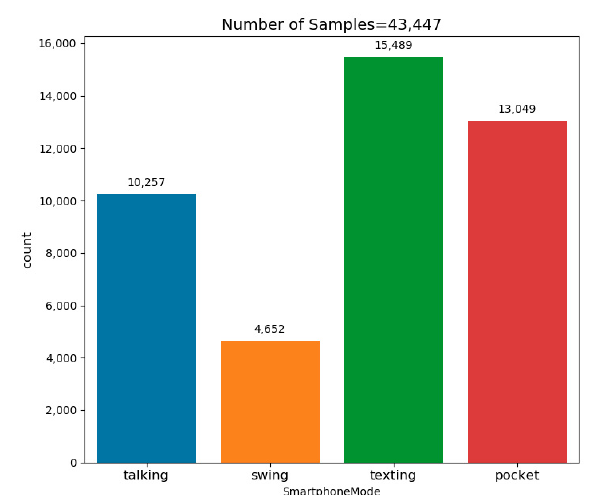
Figure A1. The HTA dataset’s sample distribution to each smartphone location.